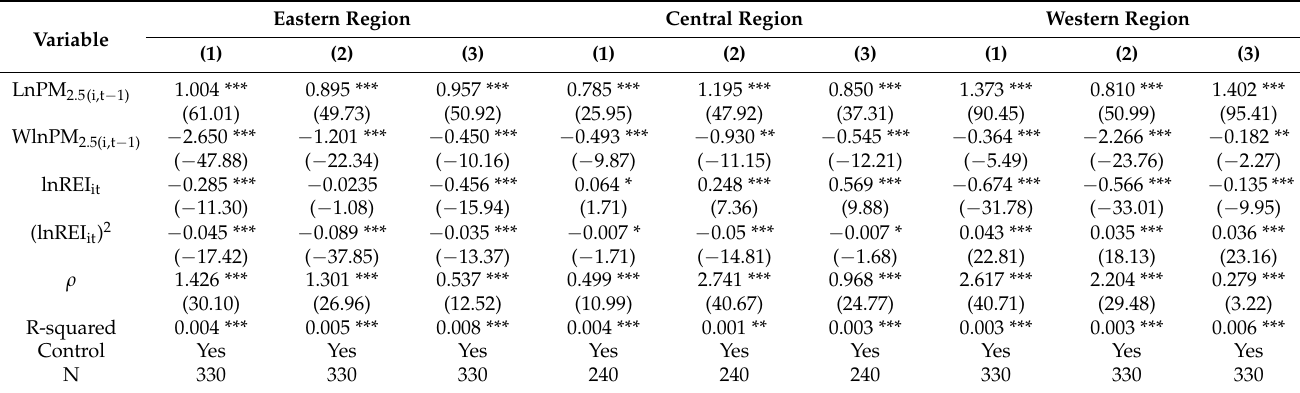
Table 7. Estimation results of the regional